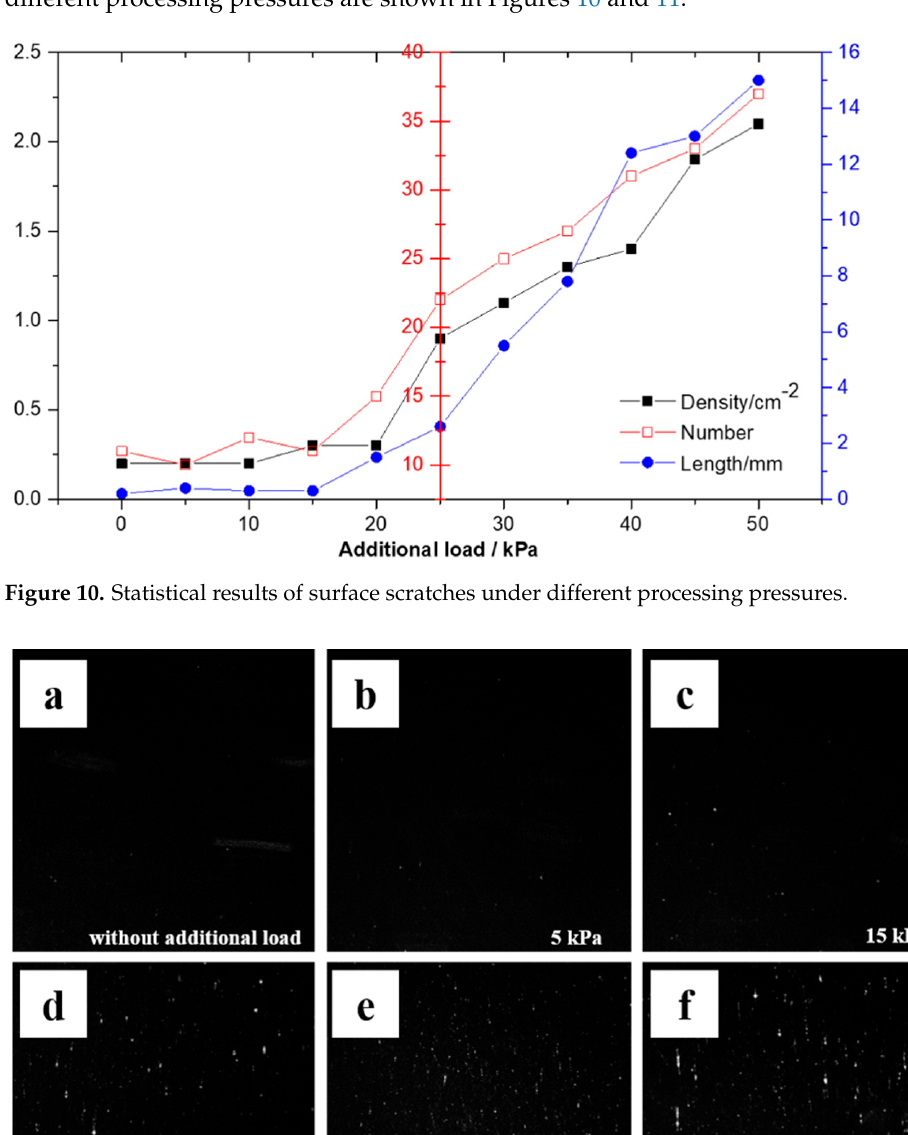
Figure 9. Initial surface quality of samples ( a ) dark field image; ( b ) bright field image; and ( c ) typical roughness distribution diagram.